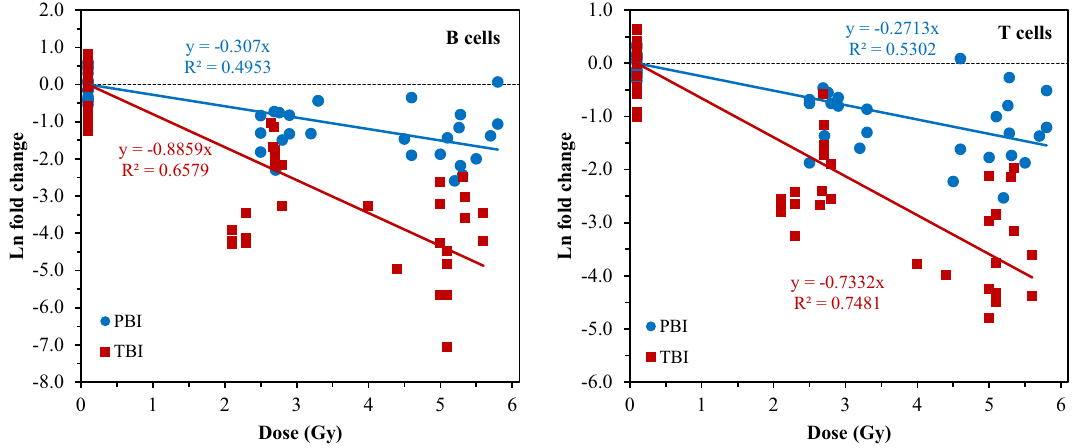
Figure 2. Radiation dose responses (ln-transformed fold changes relative to unexposed mice) for B and T cells. In this and the following figures, scatter along the x-axis represents the spread of individual mouse dosimetry estimates, which varied somewhat around the nominally prescribed doses. The data are “raw” counts from flow cytometry. The black dotted line represents zero ln fold change and indicates the baseline.